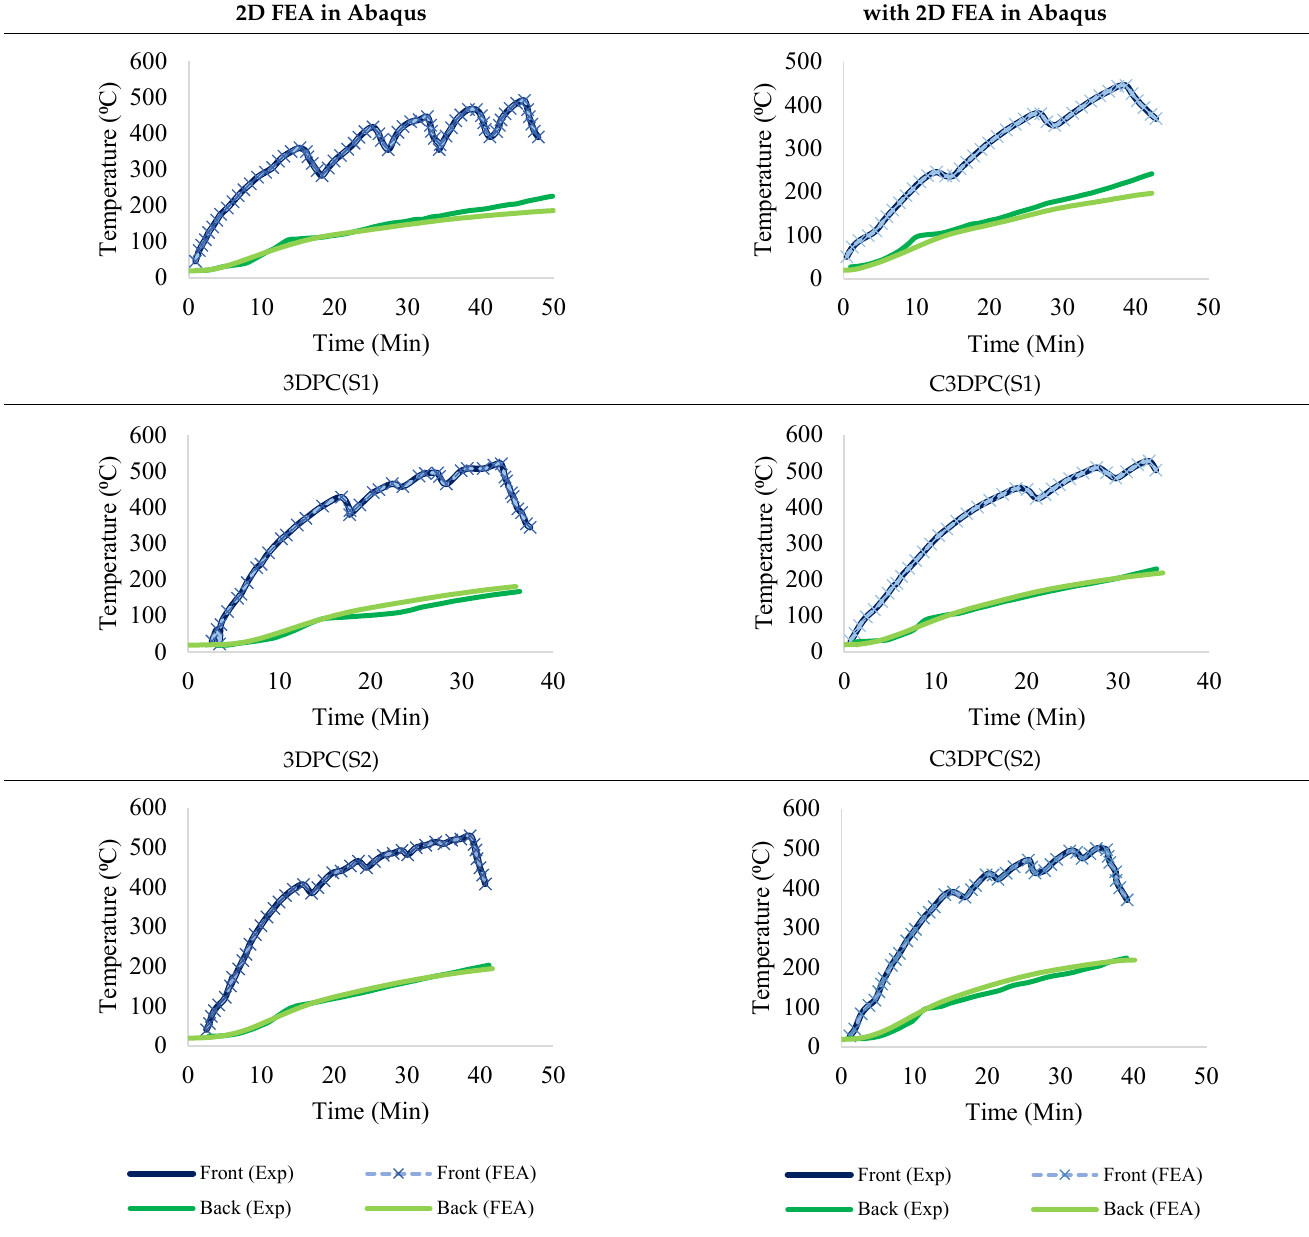
Table 2. Two-dimensional FEA Validation of 3DPC and C3CPD Samples [30]. Comparison of Experimental Results of 3DPC Samples Comparison of Experimental Results of C3DPC Samples with 2D FEA in Abaqus with 2D FEA in Abaqus